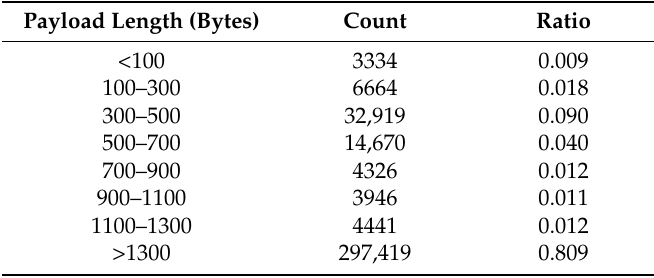
Table 2. Payload length distribution of input traffic.